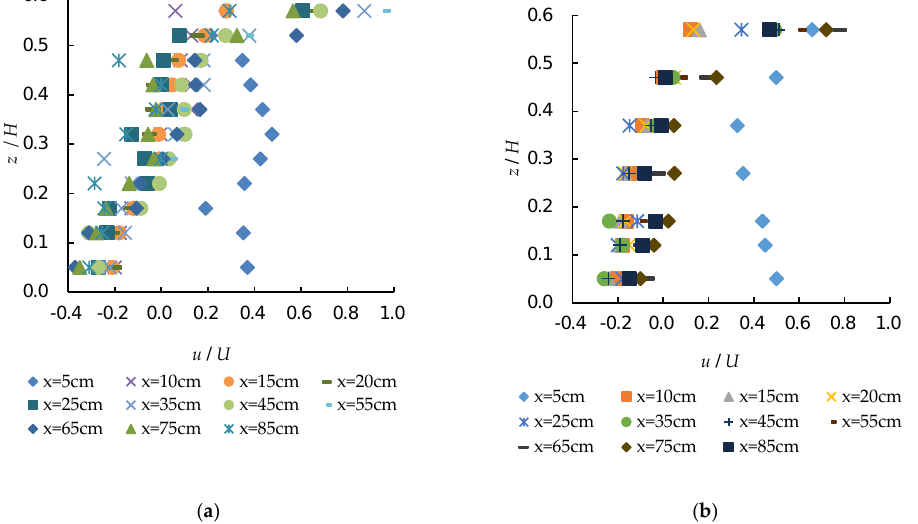
= 20.79 L / s; ( b ) Q = 30.04 L / 1 2